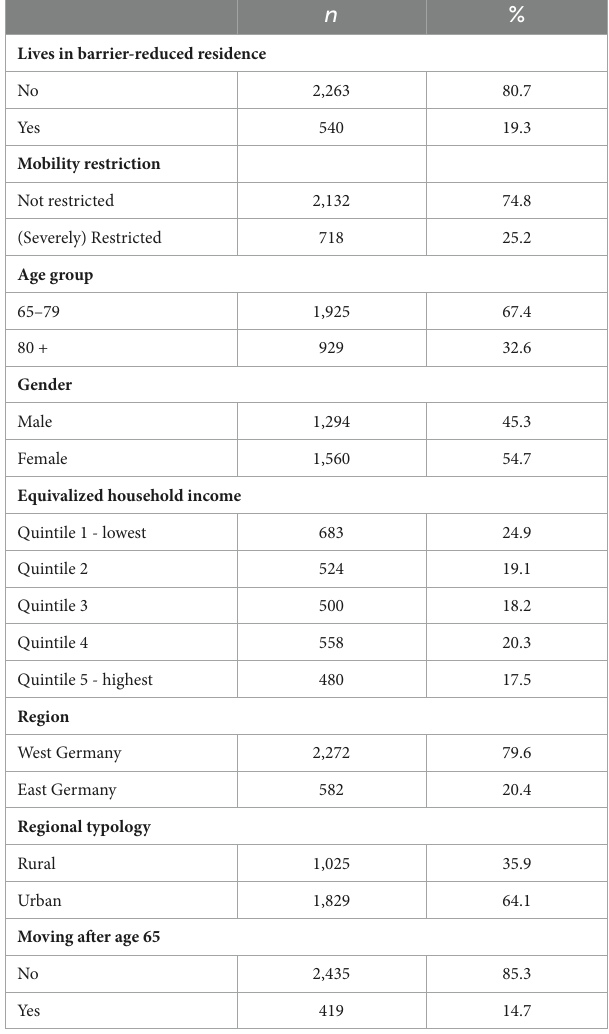
TABLE 1 Sample characteristics of participants ( n ,